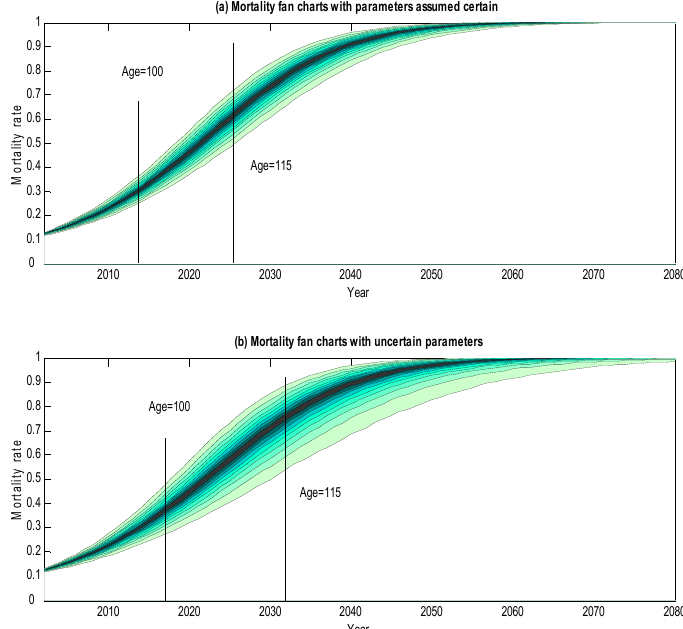
Figure 3. Mortality Fan Charts for Cohorts of Males Currently Aged 85 Years Old. Notes: As per Figure 1.